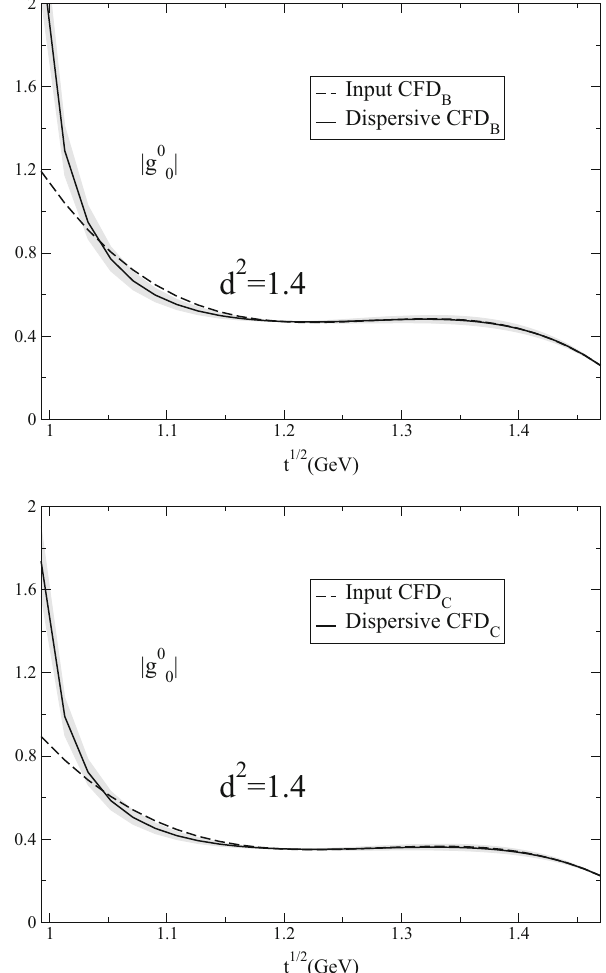
Fig. 14 Comparisonbetweentheinput(dashedline)andthedispersive output (continuous line) for the modulus of the g 0 dispersion relation in 0 Eq.(45). Intheupperpanelweshow theresultsusingasinputtheCFD B parameterization and in the lower panel those from the CFD C . The gray bands cover the uncertainty in the difference between the input and dispersive results. By comparing with Fig. 7 we see that the fulfillment of the dispersion relation by the CFD set has improved considerably with respect to the UFD parameterization. Also, there is no significant difference in the consistency of the CFD B and CFD C